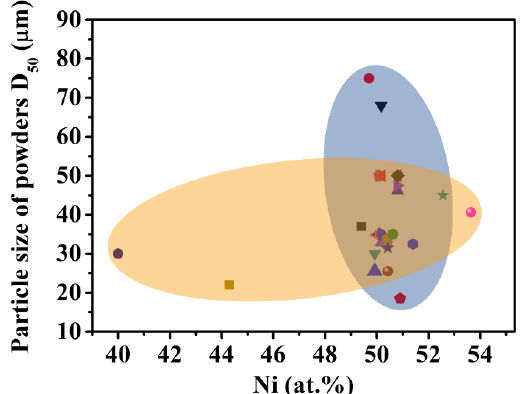
Figure 4. Atomic ratio and particle size of Ni-Ti alloy for SLM in the